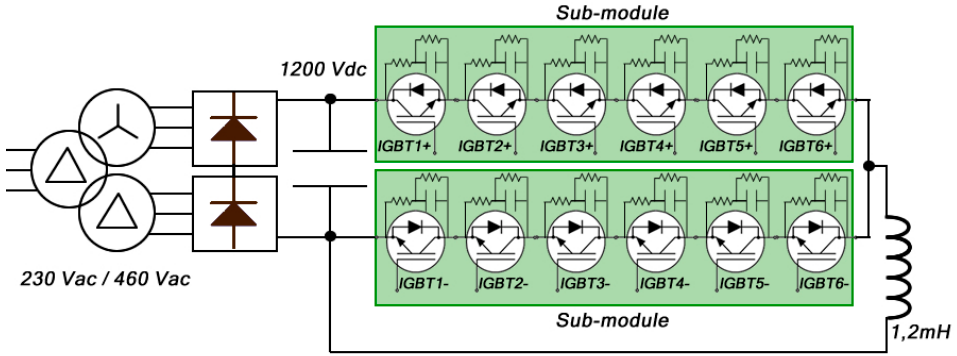
Figure 10. Power diagram of the test bench.